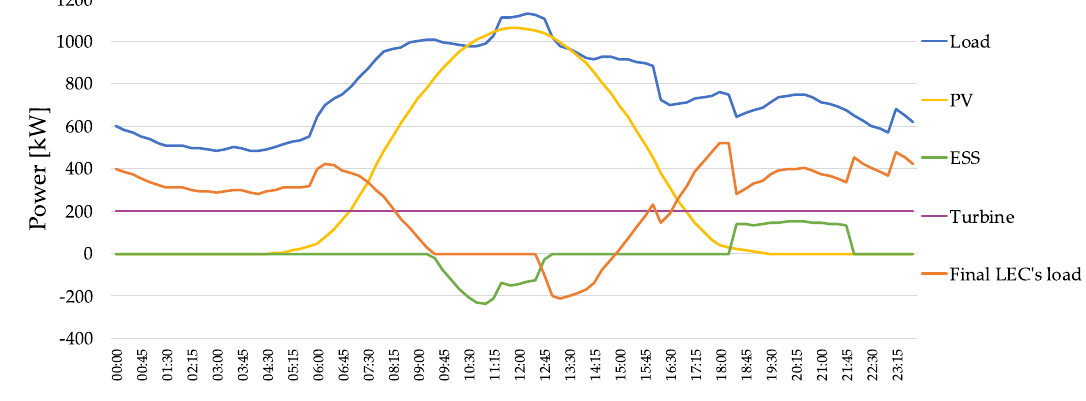
Figure 5. Final daily LEC’s load